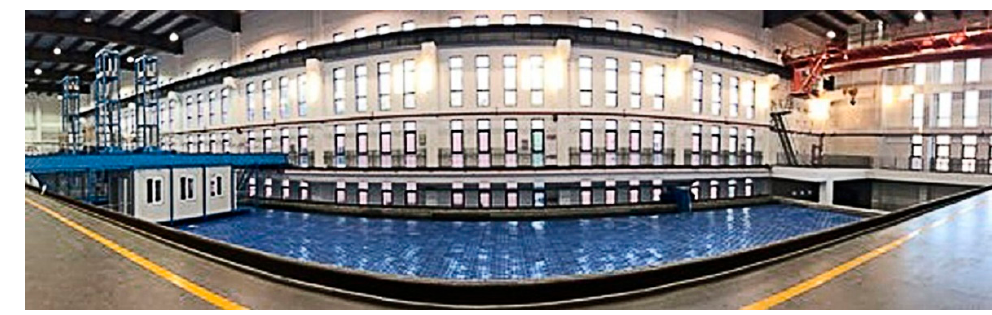
Figure 5. Anechoic